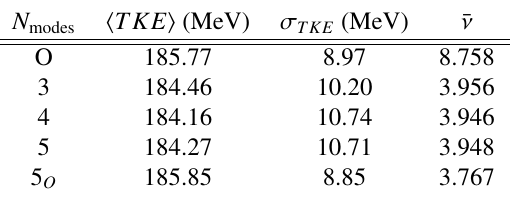
Table 1. Observables calculated from CGMF from the default parameterization (O), three, four, and five modes, as well as when five modes were fit to the default yields of CGMF (5 O ).